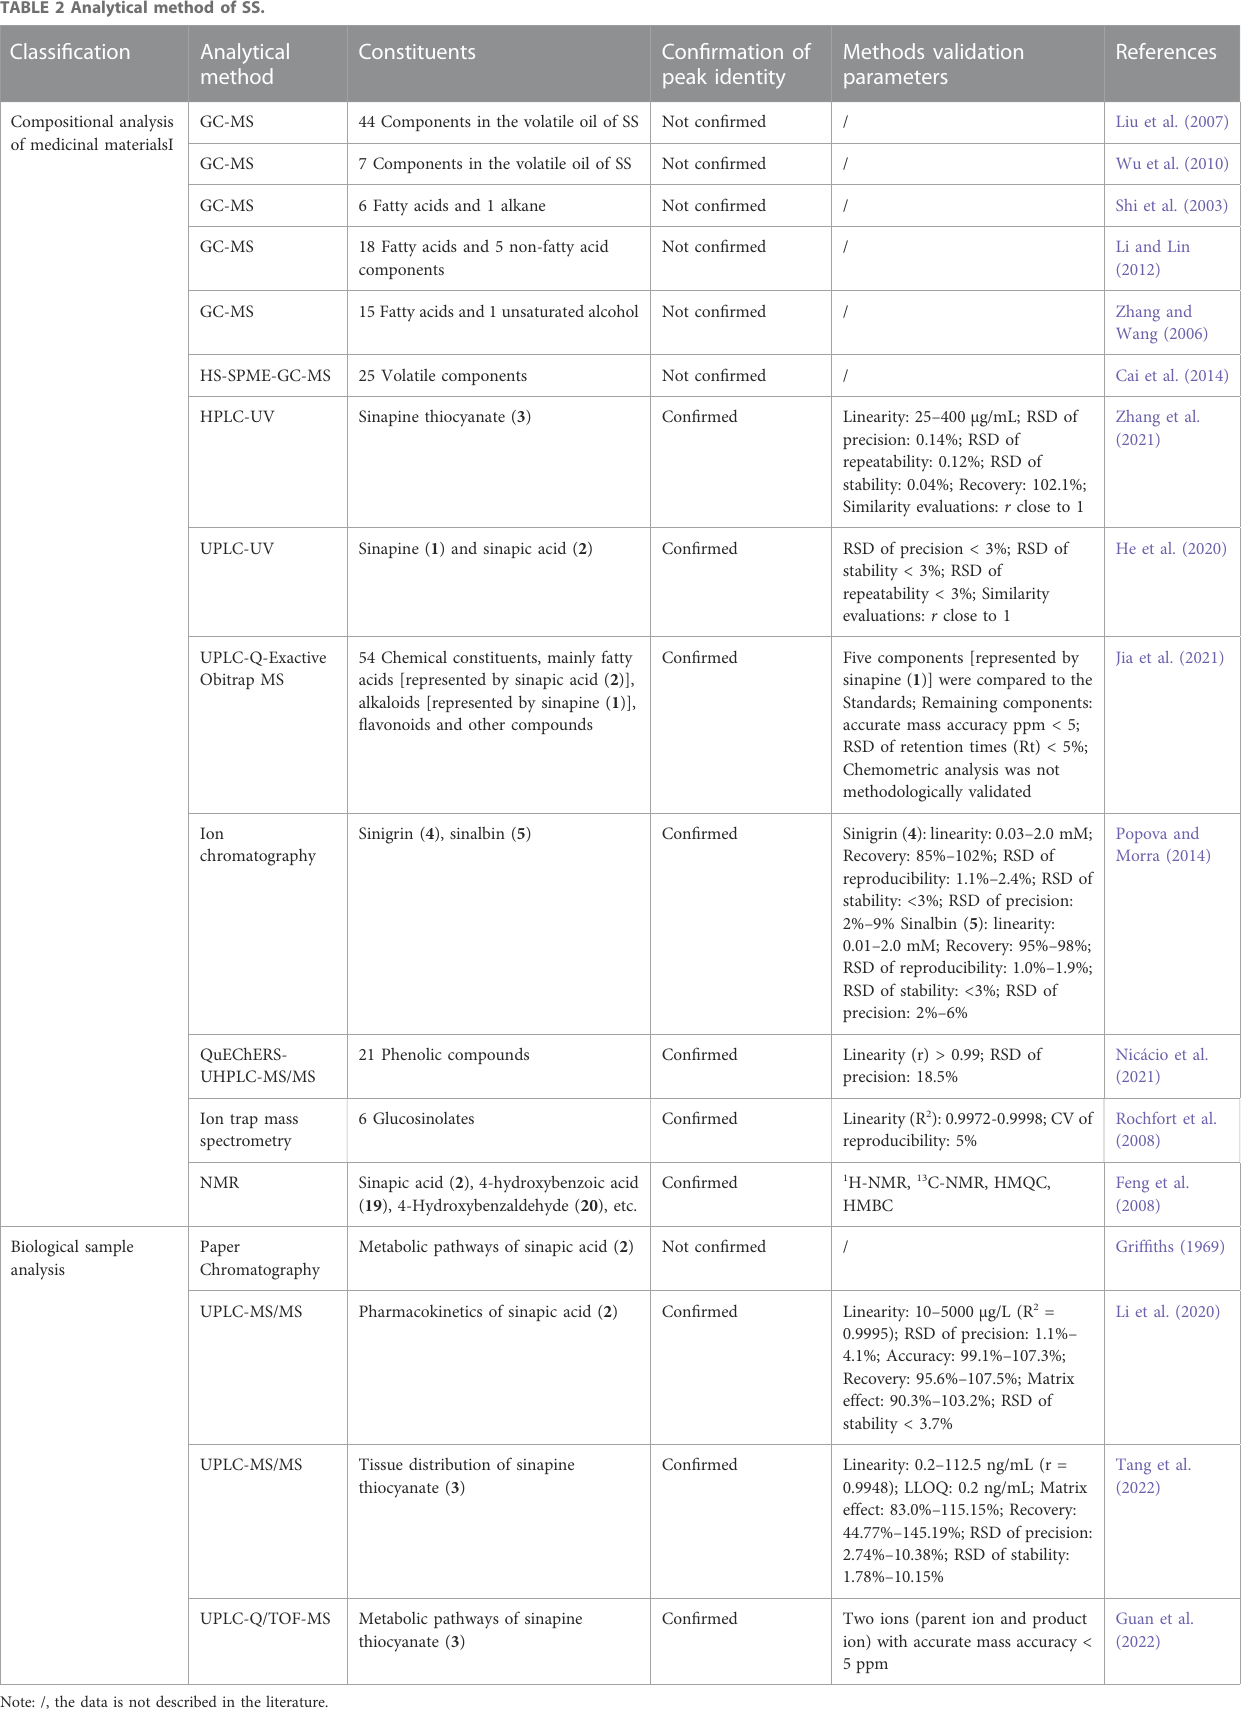
TABLE 2 Analytical method of